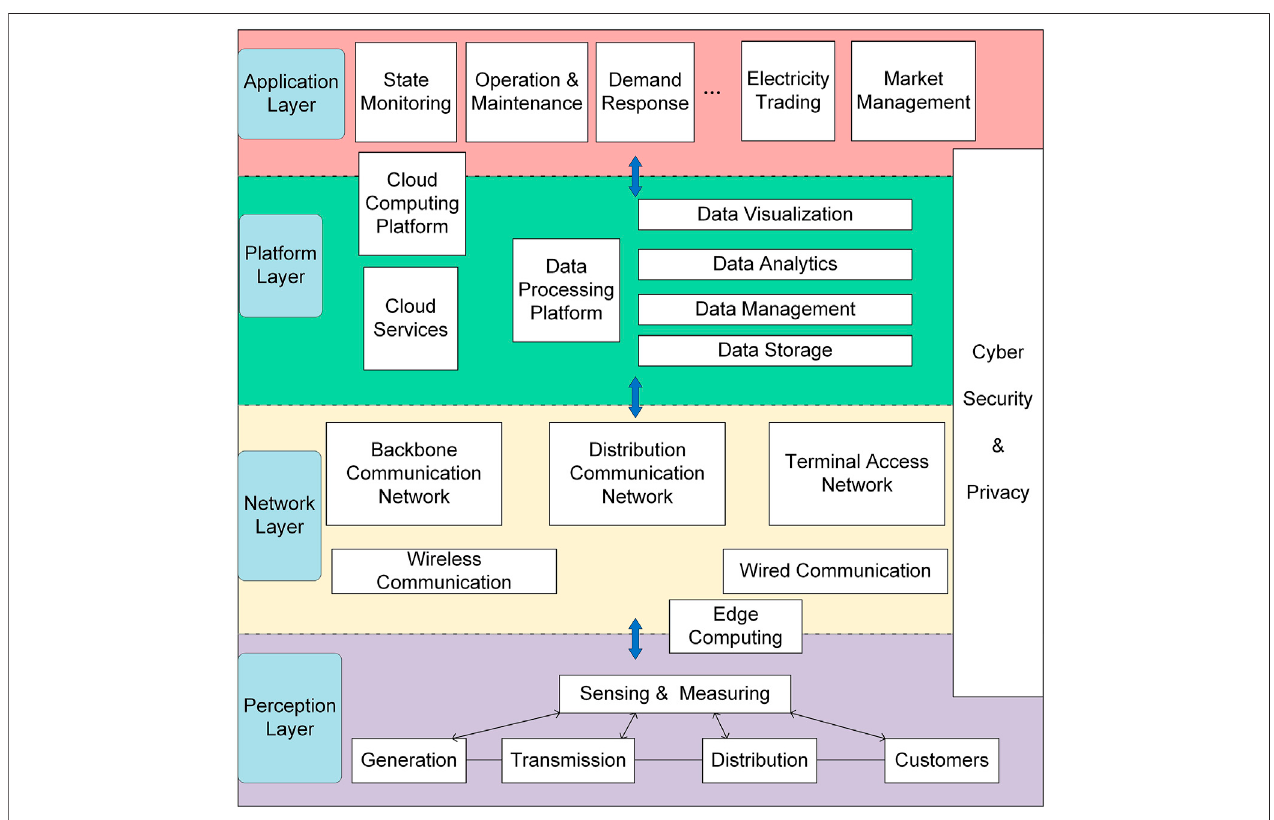
FIGURE 2 | Architecture of power